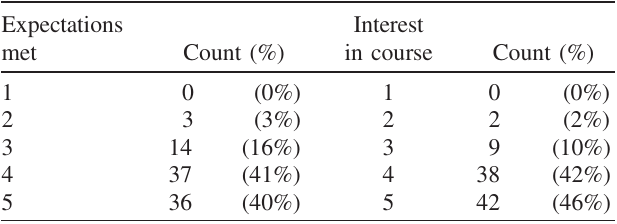
TABLE III. Students ’ postcourse views on the degree to which their expectations were met vis-à-vis the course content, and on how interesting they found the course. Here, 1 means not at all what [they] expected and not at all interesting, while 5 means exactly what [they] expected and extremely